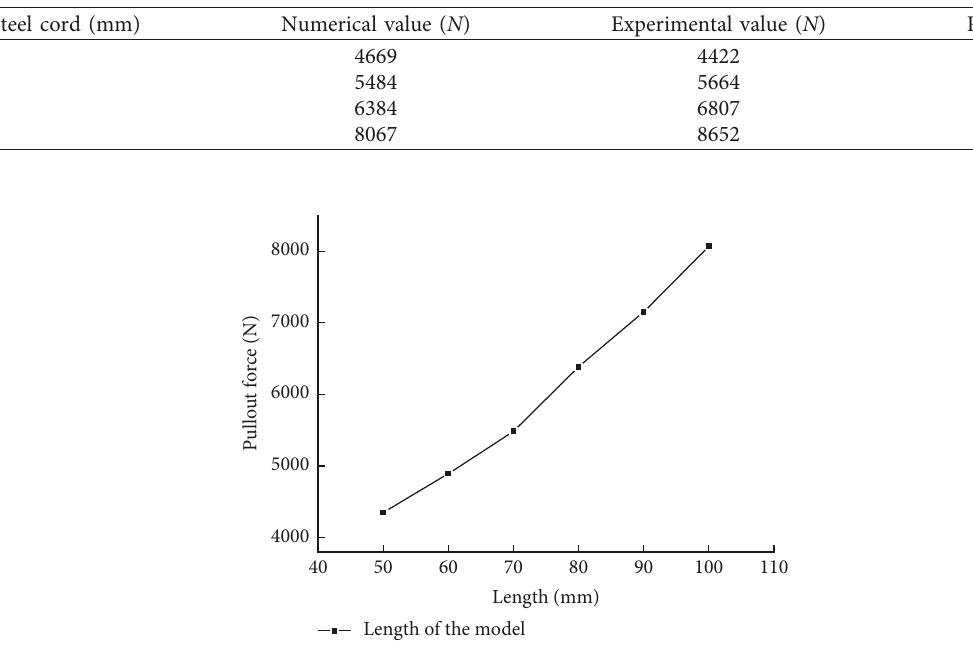
Figure 7: The change in pullout force with different